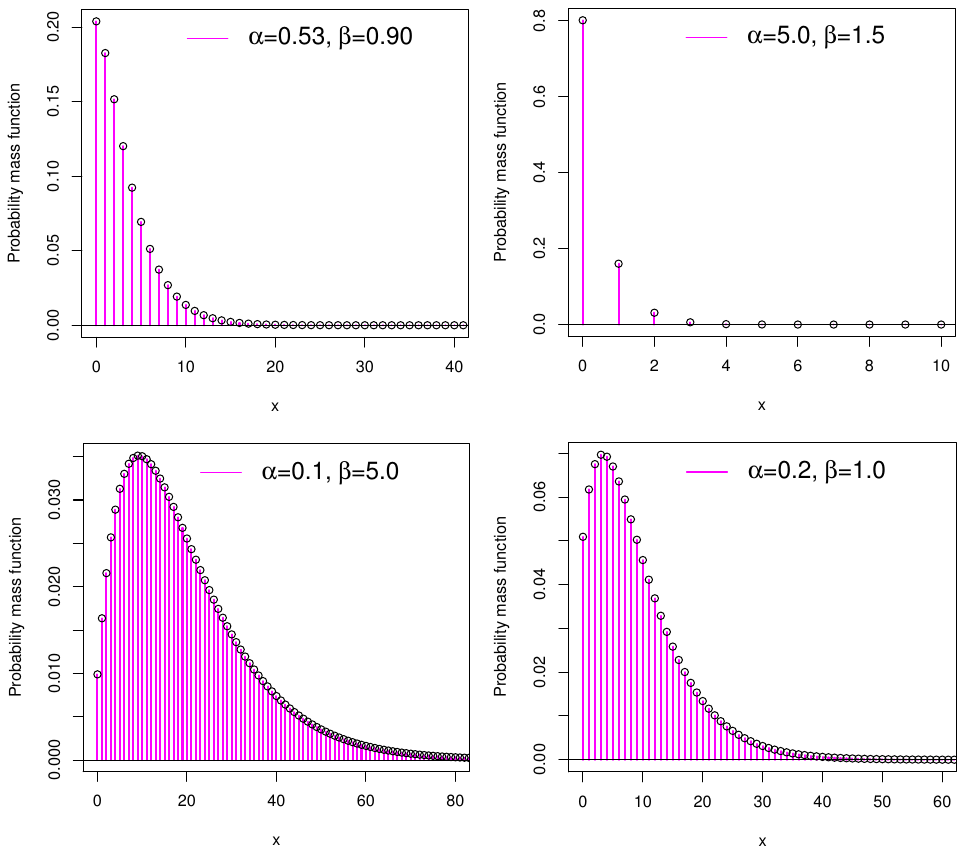
Figure 1. Various shapes of the pmfs of the PEE distribution for the varying values of the